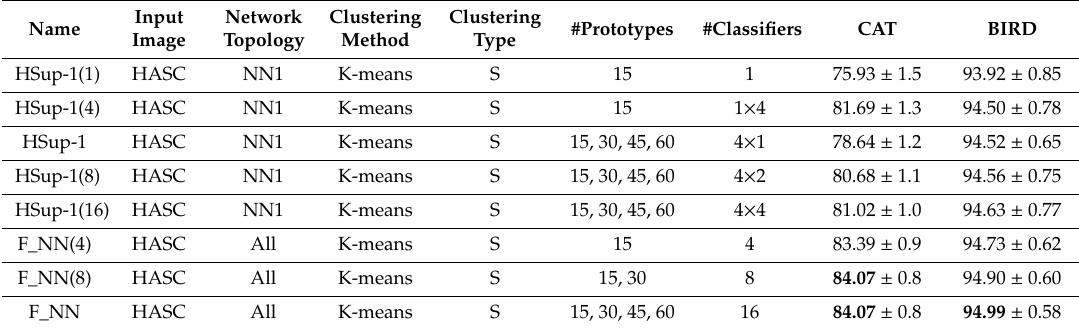
Table 5. Comparison between ensembles of reiterated Siamese Networks with NN1 and ensembles obtained considering di ff erent network topologies: accuracy ± standard deviation.